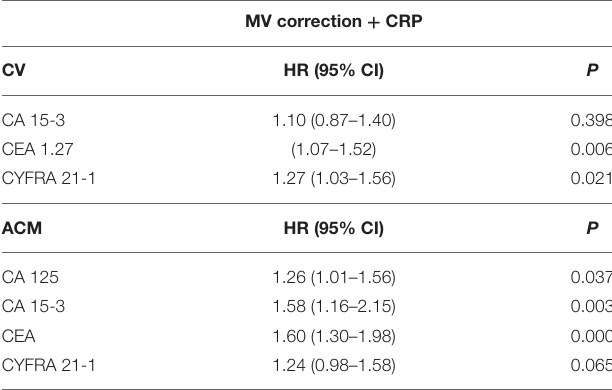
TABLE 5 | Correlation of tumour biomarker levels, CV morbidity and mortality, and